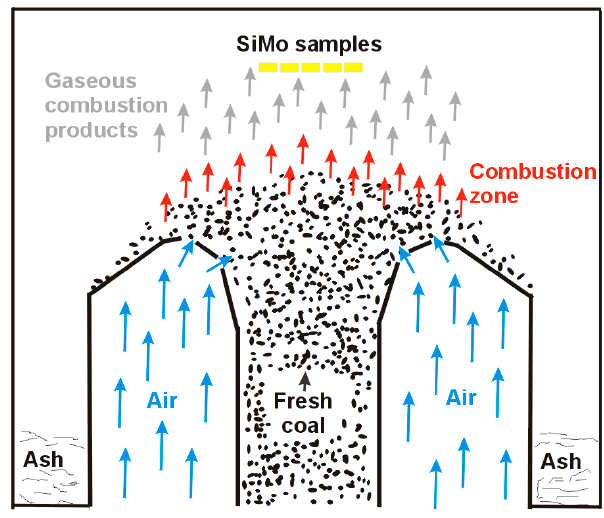
Figure 1. Scheme of a single retort with (yellow) SiMo samples placed above the stoker. Table 1. Chemical composition of the tested SiMo cast